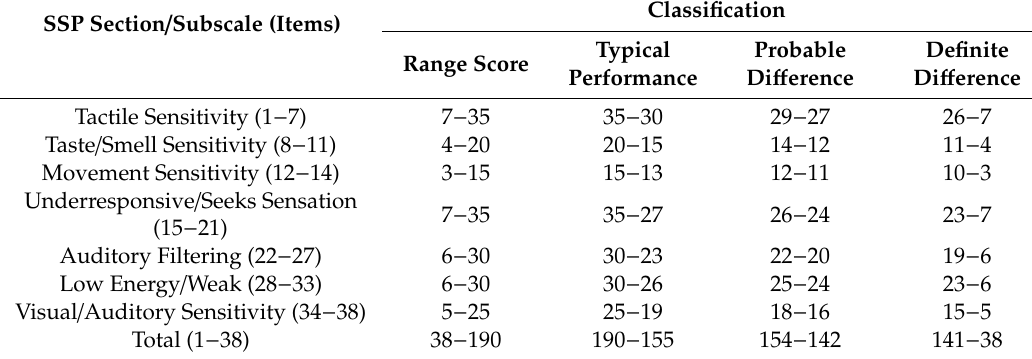
Table 2. Summary of the scores for the SSP total and total SSP subscales and classification of the child sensory